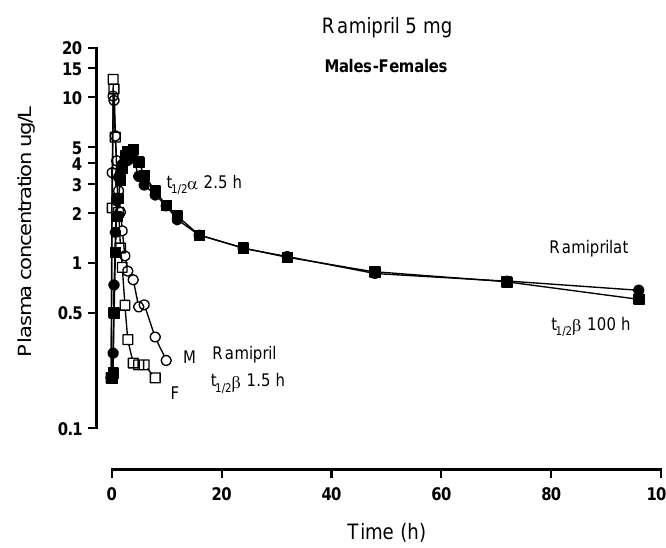
FIGURE 1. Mean plasma concentration-time curves of ramipril (open markers) and its metabolite, ramiprilat (solid markers), in 16 males (M, dots) and 18 females (F, squares) after the oral administration of 5 mg ramipril (Formulation I). Males and females show identical mean plasma concentration curves. Similar results were obtained when after administration of Formulation II. SD bars are omitted for reasons of clarity. The 50% ACE activity is present at 1 ng/mL (1 µ